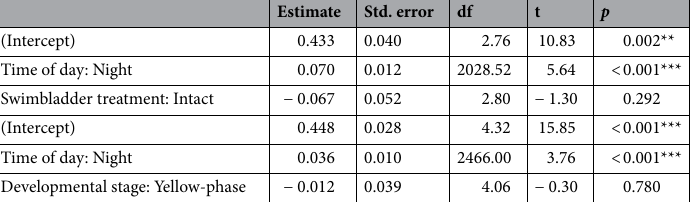
swimming in an irregular manner in very shallow water during the first day (Fig. 4). The swimming directions of this eel indicate that it moved in a northerly direction when the Sun culminated in the southern sky (Fig. 3B). A meta-analysis among the ten tracked individuals was performed to examine whether the swimming along the north–south and east–west axis was associated with the latitudinal and longitudinal positions of the tracking area. In the meridional axis (north–south), the swimming trajectories of eels released in the KC area showed that they swam southward from the release points (Fig. 2A), whereas those of eels released in the TS area, except WE4265_TS (released at 20°N), demonstrate that they swam northward from the release points (Fig. 2B). The 10-min interval swimming vectors of eels released at 12° to 13° N tended to have northward components (0–90° and 270–360°) with significantly higher frequencies, whereas the swimming vectors of eels released at 20° to 34° N tended to have southward components (90°–270°) with significantly higher frequencies (Fig. 5A). In the zonal axis (east–west), swimming vectors with westward components (180°–360°) were more fre- quently observed in eels released at the TS area than in eels at the KC area (Fig. 5B). Their tendency to swim in an east–west direction did not depend on the longitudinal position of the release points toward the spawning area. In addition, no notable difference was observed in these meridional and zonal movements between day and night.